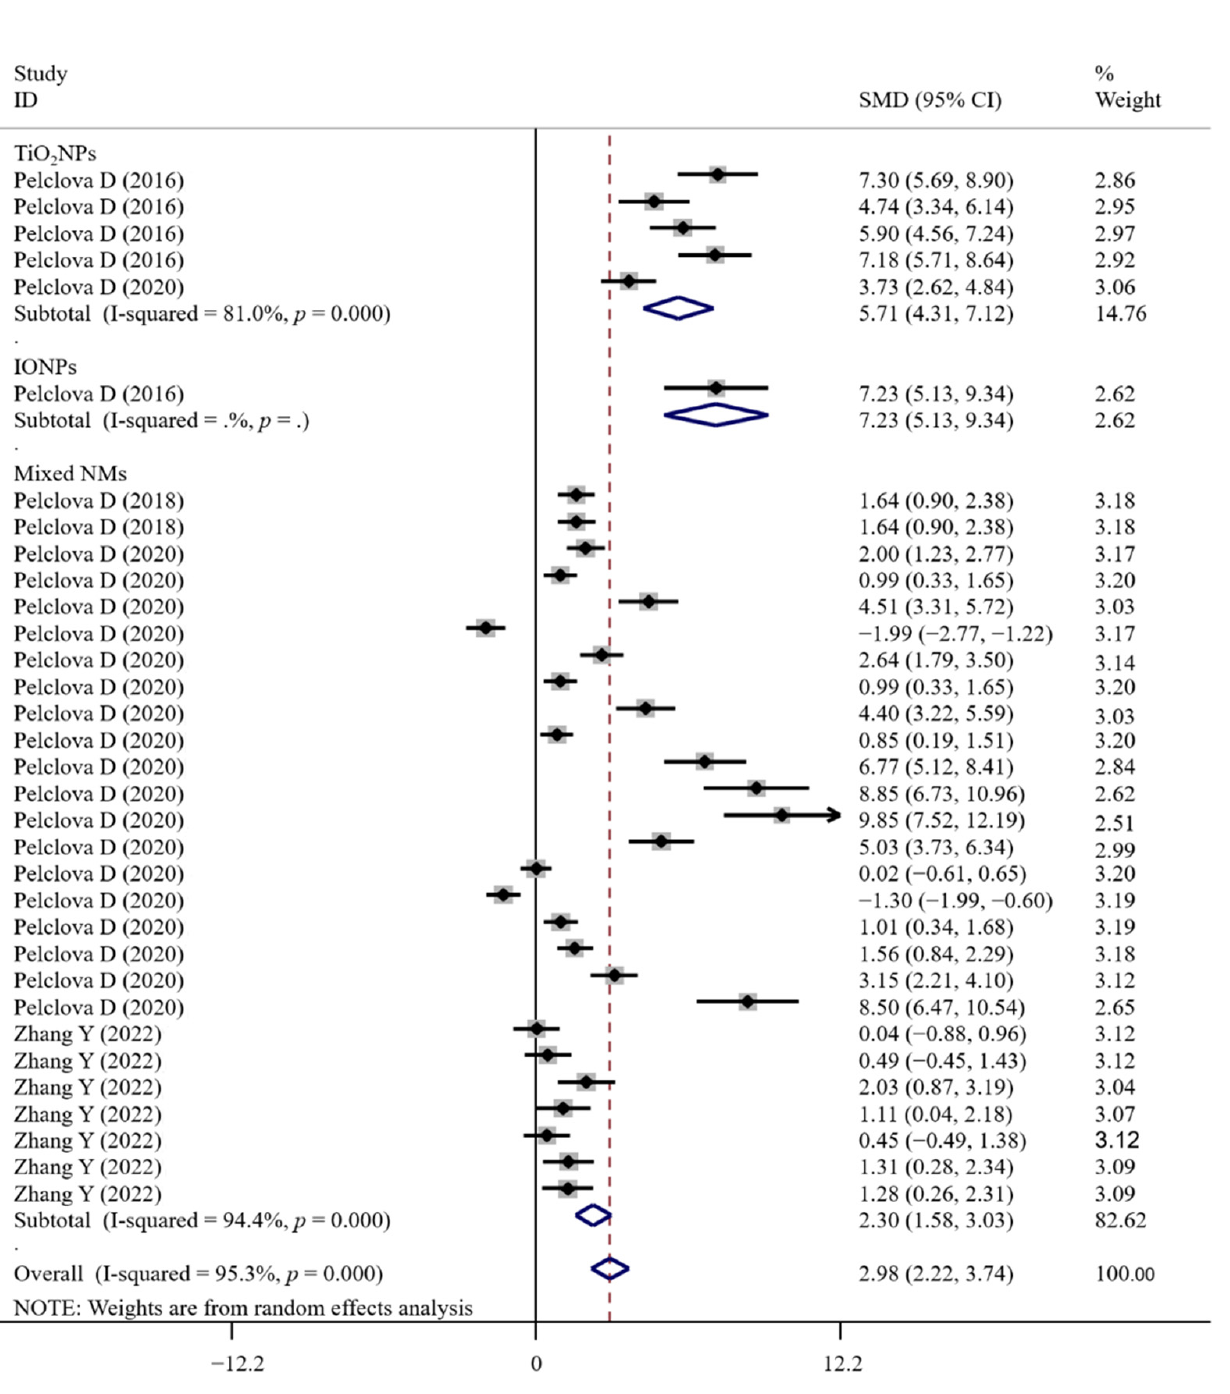
Figure 3. Forest plots assessing the effects of exposure to different NMs on the level of 8-OHG compared with the non-exposed control group. NMs, nanomaterials; IONPs, iron oxide nanoparticles; TiO 2 NPs, titanium dioxide nanoparticles; 8-OHG, 8-hydroxyguanine; SMD, standardized mean difference; CI, confidence interval [15,29,33,43,44].